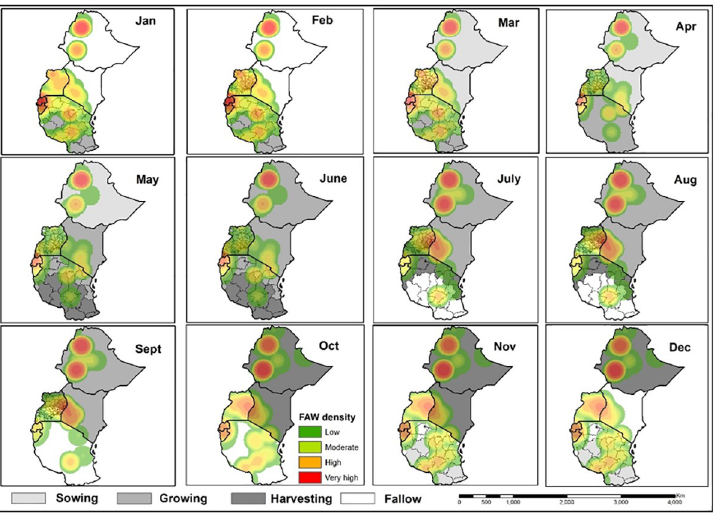
Fig 10. Maize cropping main seasons and fall armyworm trap counts dynamics in eastern Africa.